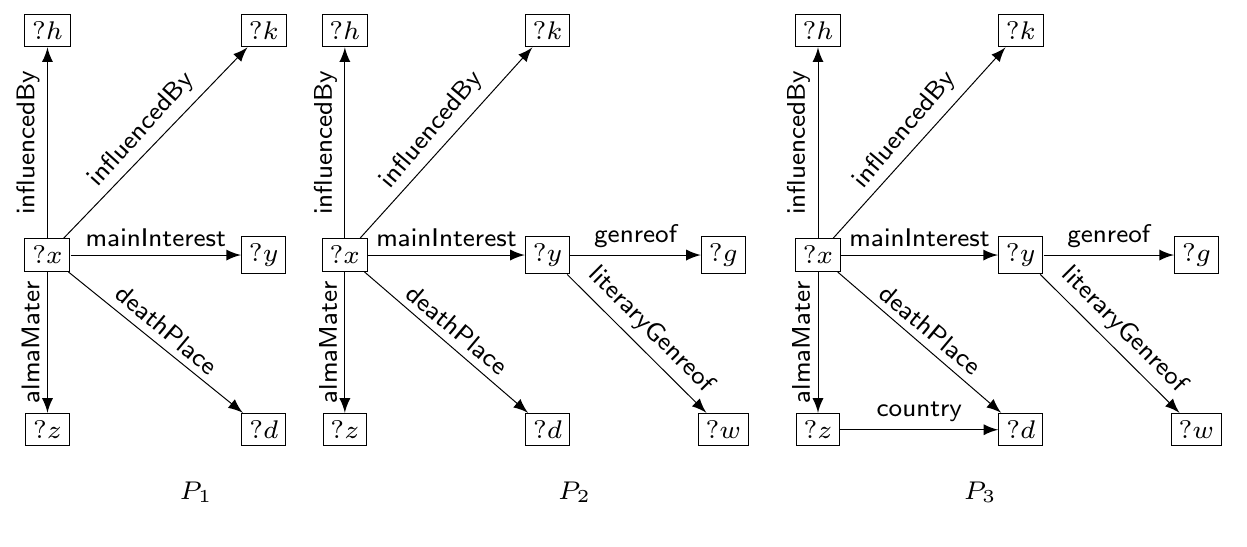
Fig. 2 The query graph and star decomposition of query Q